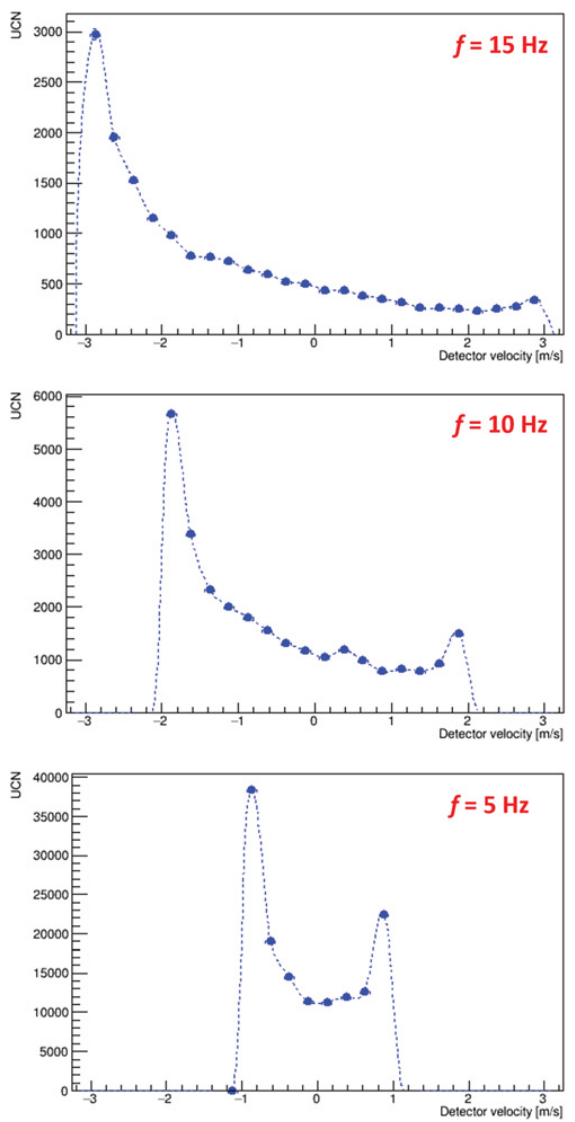
Figure 9. Detector velocity distributions extracted from a sample of data taken at West-1 port of the PSI UCN